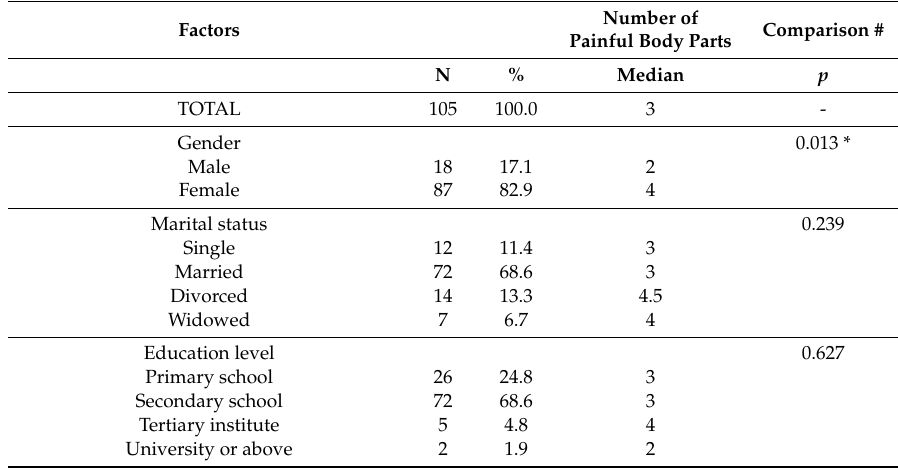
Table 1. Characteristics of participants, and the association of factors and number of body parts with WRMSs at baseline